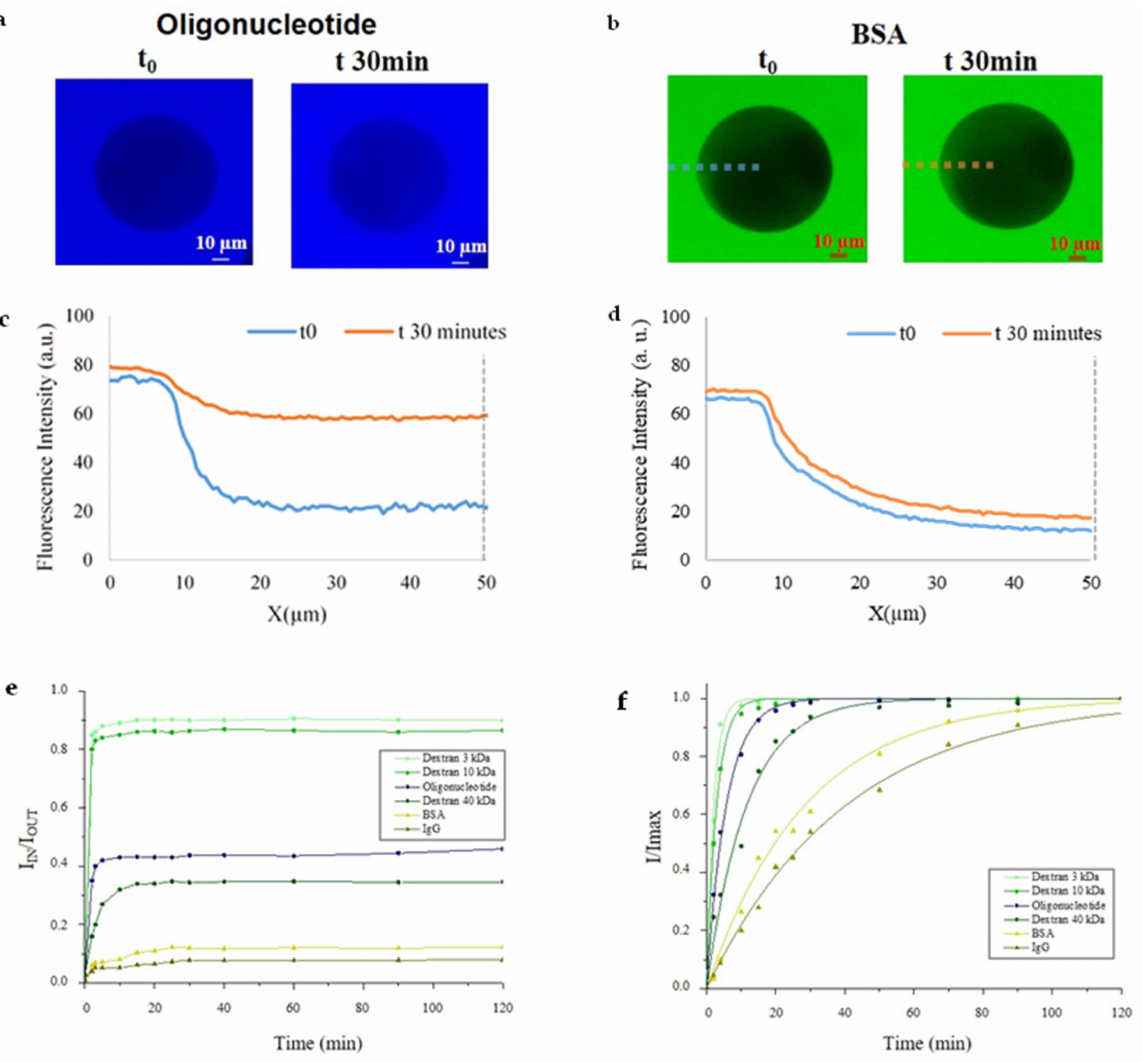
Figure 2. CLSM images at different time points (0 min and 30 min) for ( a ) Oligonucleotide and ( b ) BSA. Plot profile of fluorescence intensity of Oligonucleotide ( c , d ) BSA Protein. Diffusion in microparticles: ( e ) Time lapse of fluorescence intensity (I IN /I OUT ) of several probes. ( f ) Time lapse of fluorescence intensity (I/Imax) of several probes. All values reported show a standard deviation of